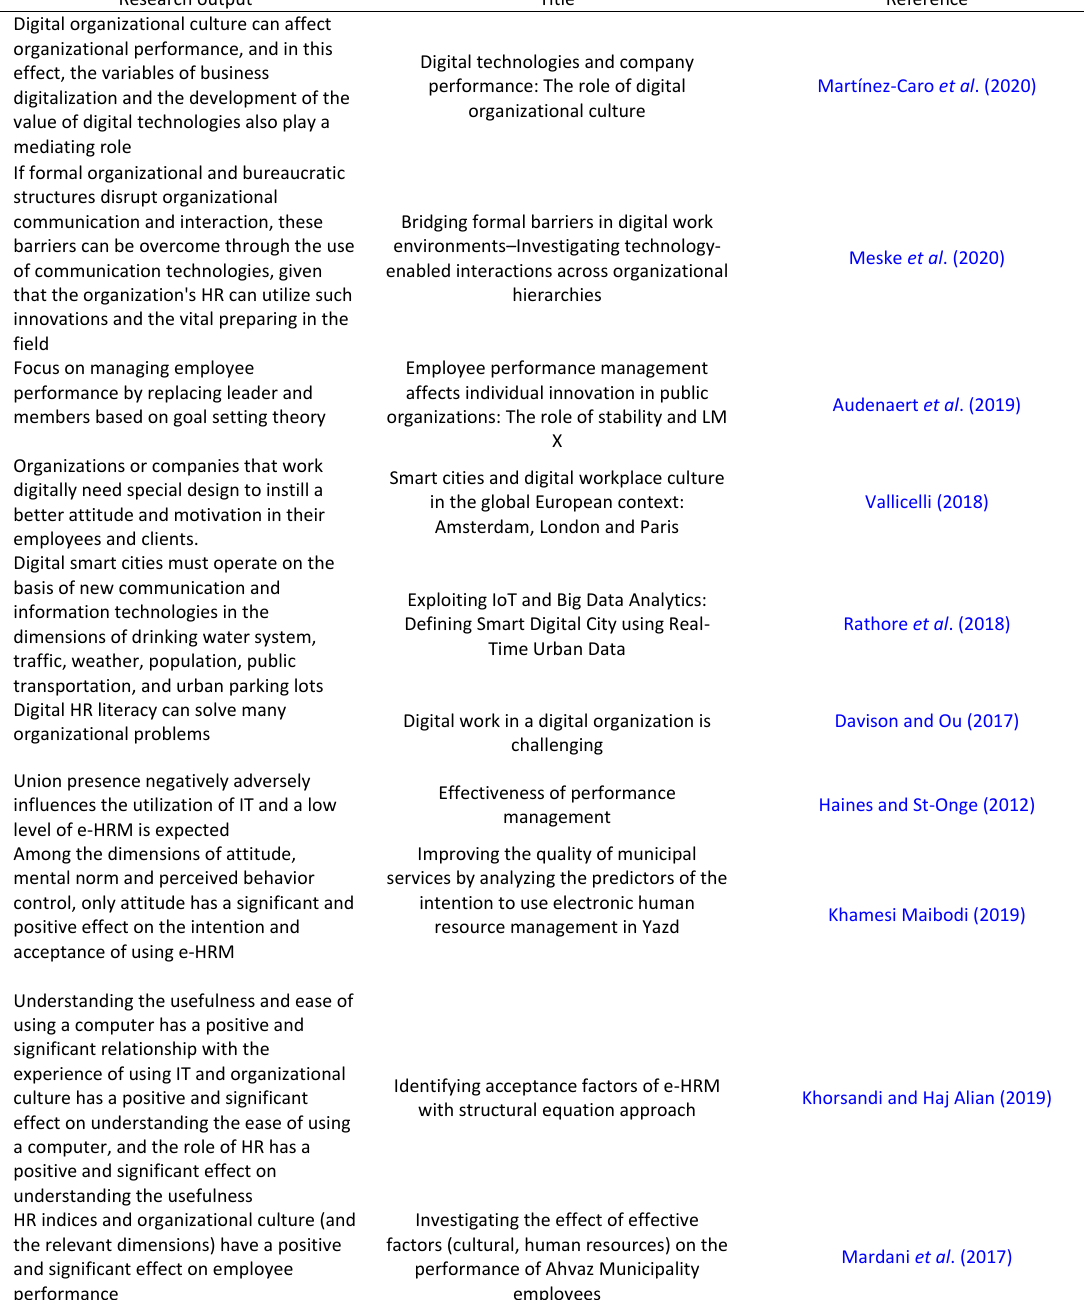
Table 2: National and international studies on research background Research output